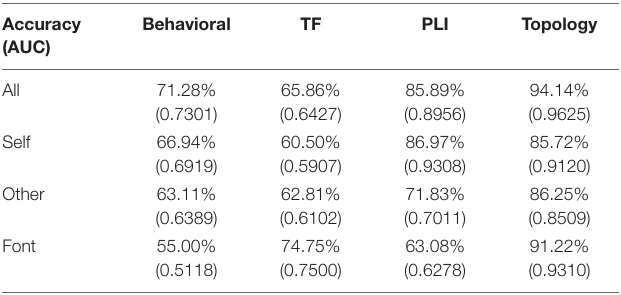
TABLE 1 | Accuracy and AUC of discriminating bipolar disorder from normal controls by the classifier based on machine learning methods. Accuracy Behavioral TF PLI (AUC)